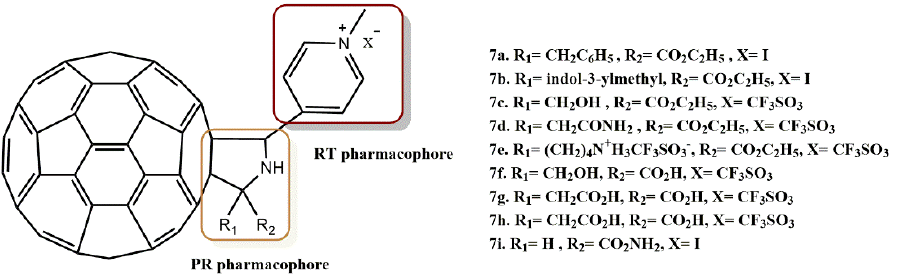
Figure 8. RT and PR pharmacophores of new active synthesized compounds 6a and 6b .